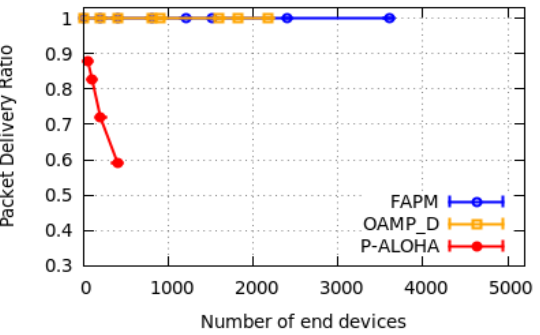
Figure 12. PDR of FAPM, OAPM_D and pure Aloha in C 5,15,30,35,10,5 with 3 channels versus the number of End